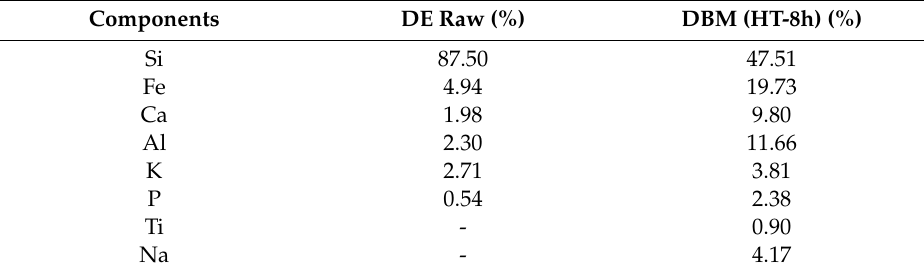
Table 1. Principal components (in weight percentage) of raw diatomite (DE) and DE-based materials (DBM) obtained after hydrothermal treatment for 8 h after annealing at 550 °C (HT-8h).